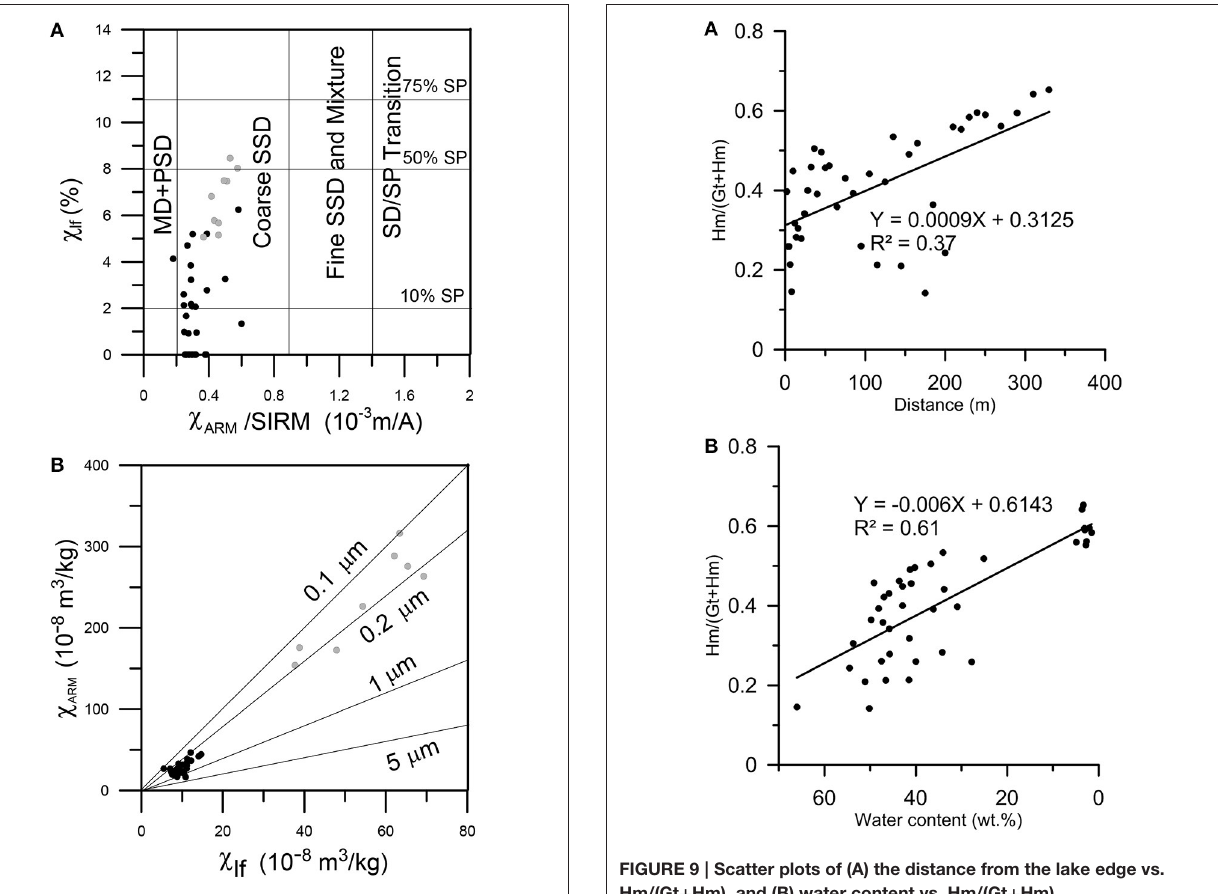
FIGURE 8 | (A) Dearing plots and (B) King plots. Black (gray) dots represent wet (dry) grassland samples.